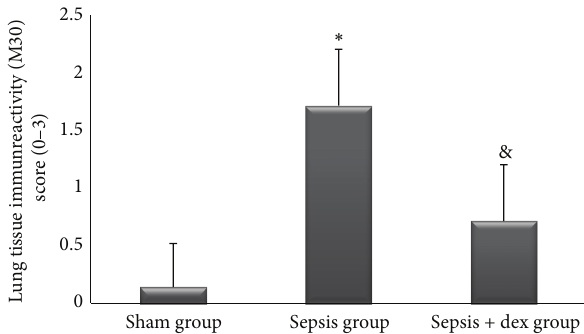
Figure 9: Lung tissue immunoreactivity scores in experimental groups. ∗ 𝑃 < 0.05 compared with sham and sepsis + dex groups. & 𝑃 < 0.05 compared with sham group.